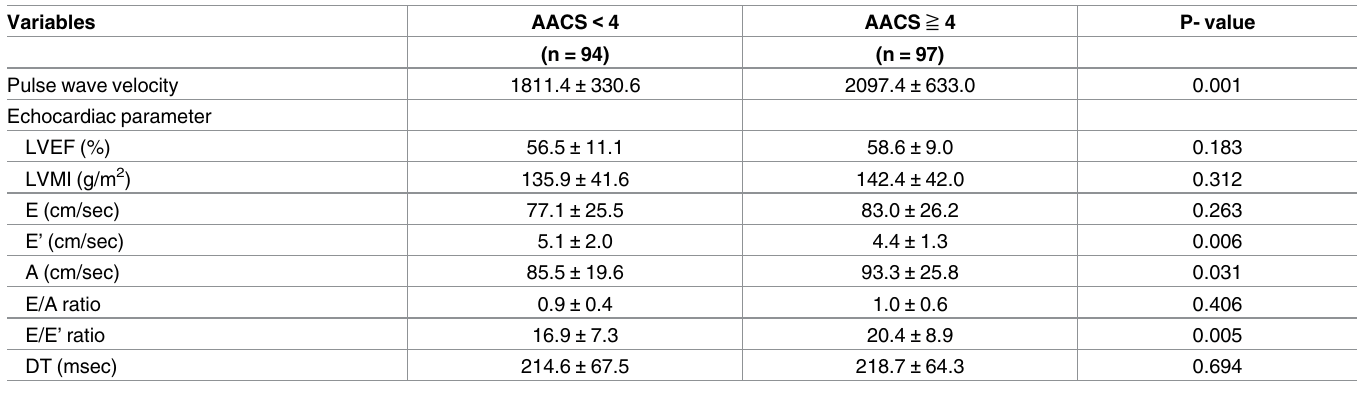
Table 3. Pulse wave velocity and echocardiographic index according to